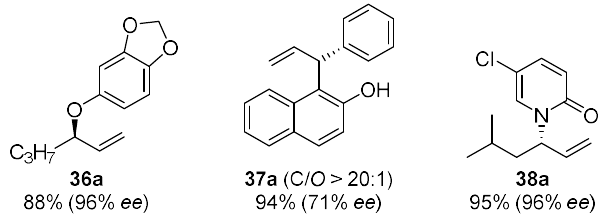
Figure 3. Products of O -, C- and N -allylation 36a , 37a and 38a , respectively.